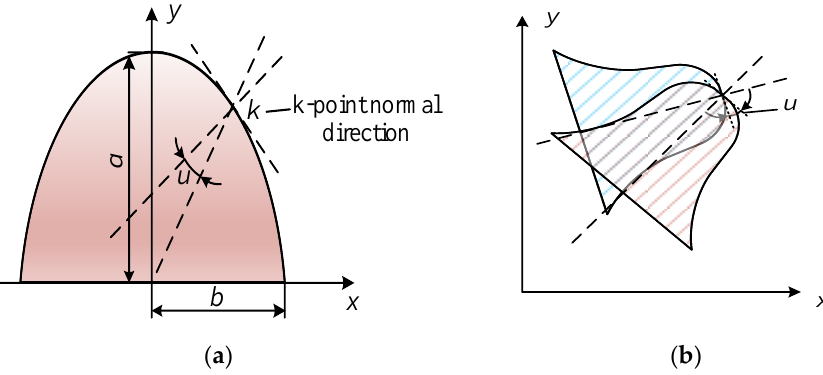
Figure 7. Gear tooth deviation: ( a ) in its entirety; ( b ) for a single tooth.